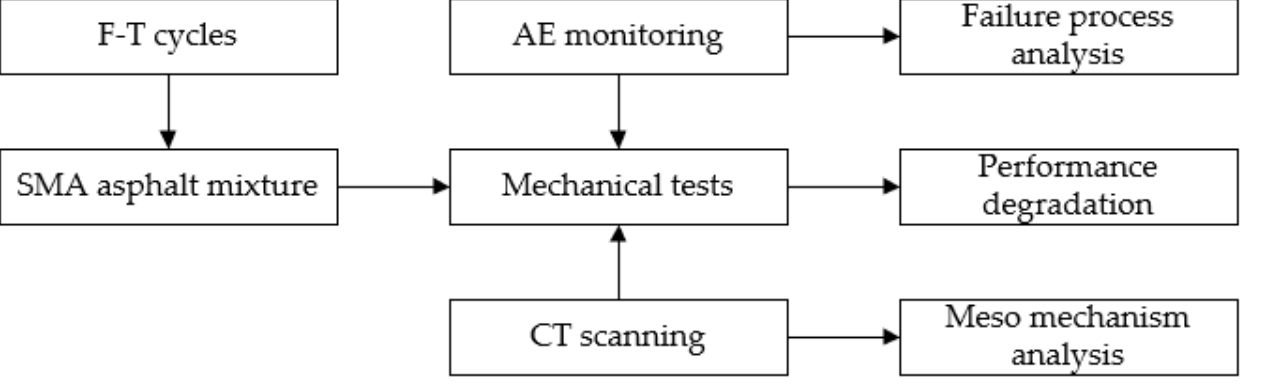
Figure 1. The flowchart of this study.